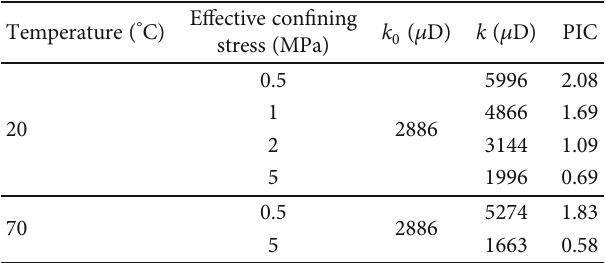
Figure 12: Axial strain-deviatoric stress curves and axial strain-volumetric strain curves under varying e ff ective con fi ning stresses and temperatures [8]. Table 2: Permeability changes of oil sands before and after shear.